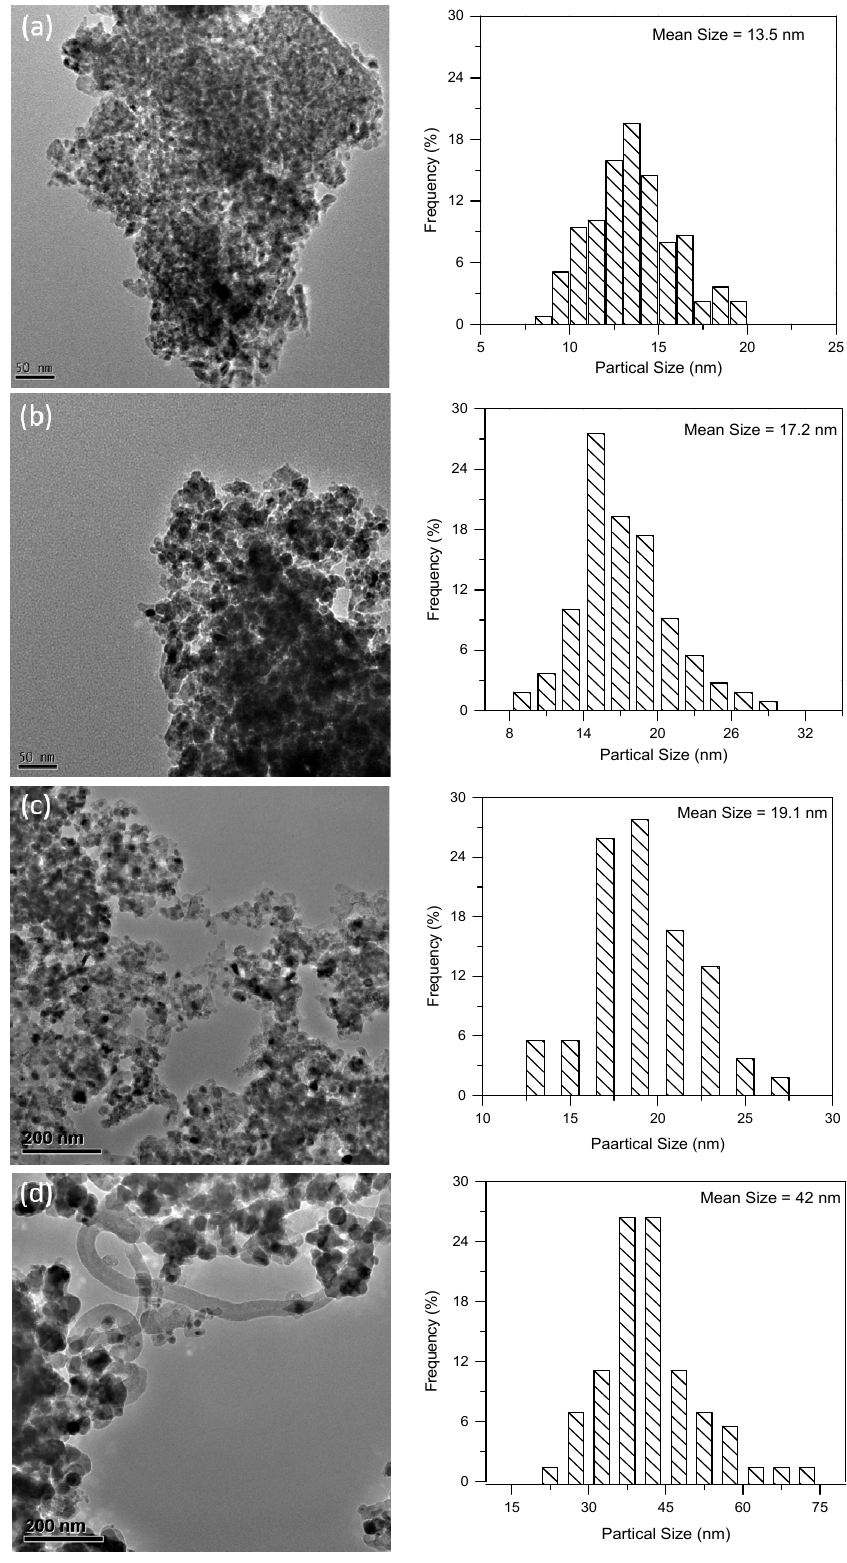
Figure 4. TEM images of as-reduced catalysts ( a ) Co 2 Zn 1 Sc 0.3 and ( b ) Co 2 Zn 1 , and the spent catalysts ( c ) Co 2 Zn 1 Sc 0.3 and ( d ) Co 2 Zn 1 . ( c ) Co 2 Zn 1 Sc 0.3 and ( d ) Co 2 Zn 1